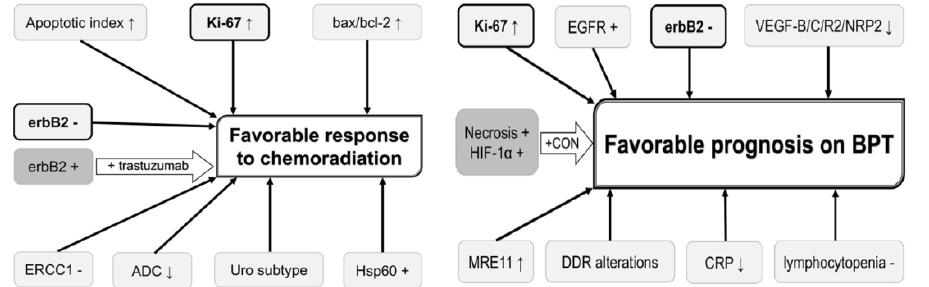
Figure 6. Potential useful biomarkers for improving prognosis in bladder preservation strategies (BPT: bladder preservation therapy).